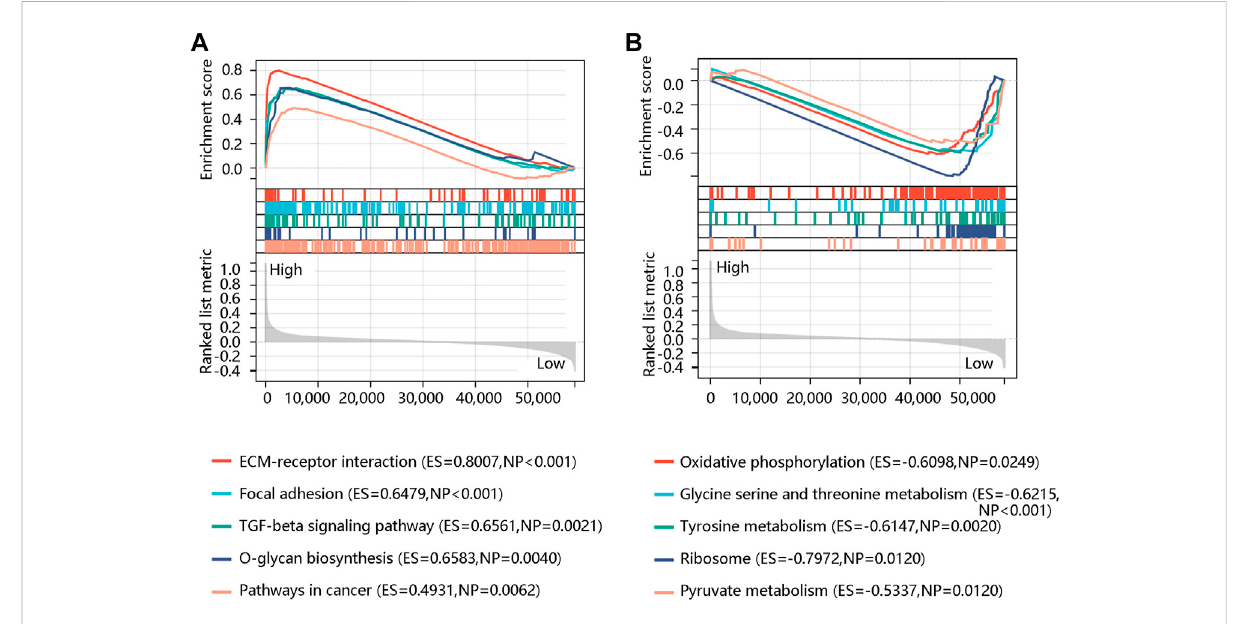
FIGURE 8 Gene set enrichment analysis showed the top fi ve signi fi cant pathways in the high (A) and low (B) FN1 expression